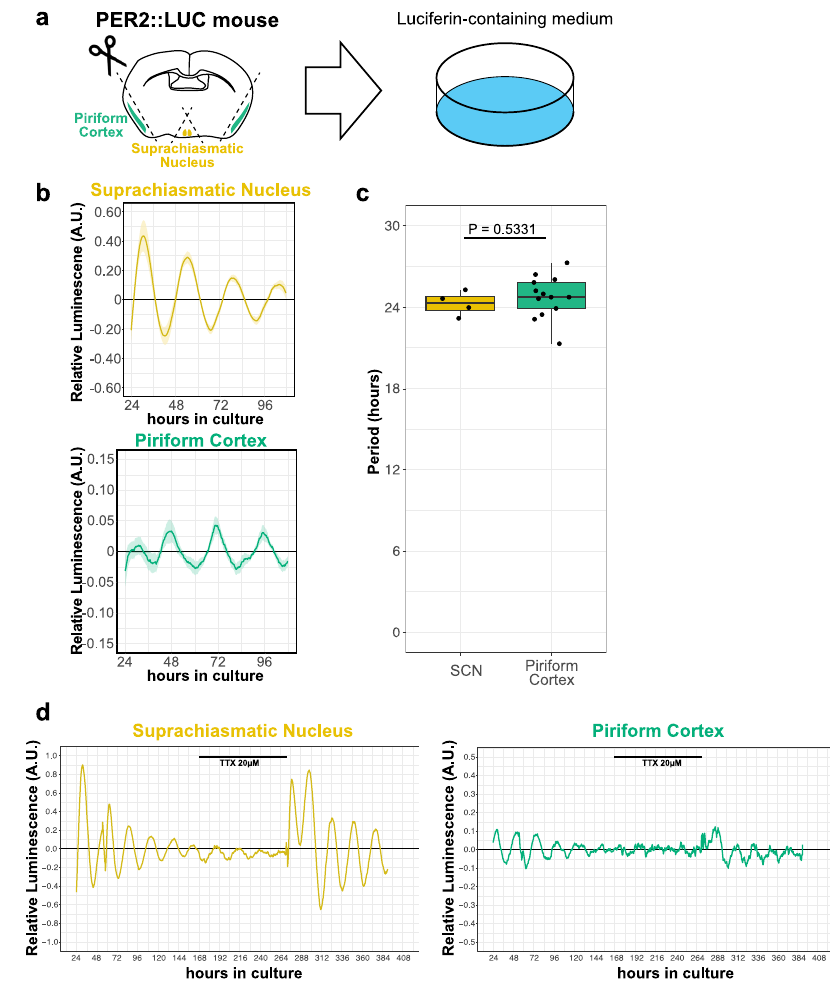
Fig. 5 Clock gene expression in the PC retains circadian rhythmicity in the absence of SCN. a Schematic illustration of luciferase assay. The PC and suprachiasmatic nucleus were cut out from PER2::LUC mice and incubated in a luciferin-containing medium for up to 1 week. b Luminescence levels of the suprachiasmatic nucleus and the PC. Lines indicate the mean luminescence levels, and the shade indicates the mean ± standard error. c Mean period of the suprachiasmatic nucleus and PC. Periods were calculated by the Lomb-Scargle periodogram analysis. N = 4, 24.4 ± 1.10 h; N = 13, 24.73 ± 0.43 h, for the SCN and PC, respectively. p = 0.5331, Wilcoxon rank-sum test. The line at the center of each boxplot depicts the median; the box depicts the third quartile and fi rst quartile. d Representative graphs of the luminescence levels of the SCN and the PC with TTX